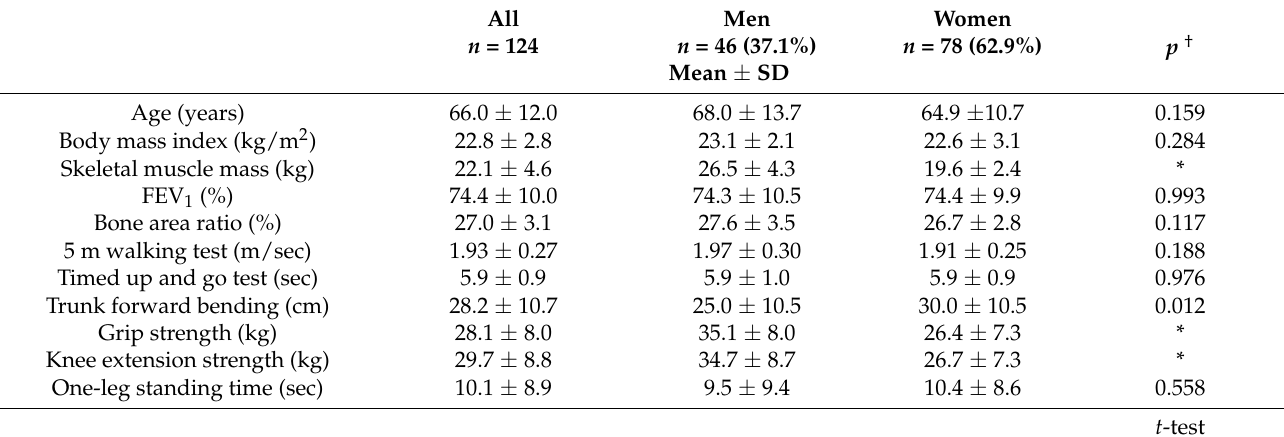
Table 1. Characteristics of the study subjects.